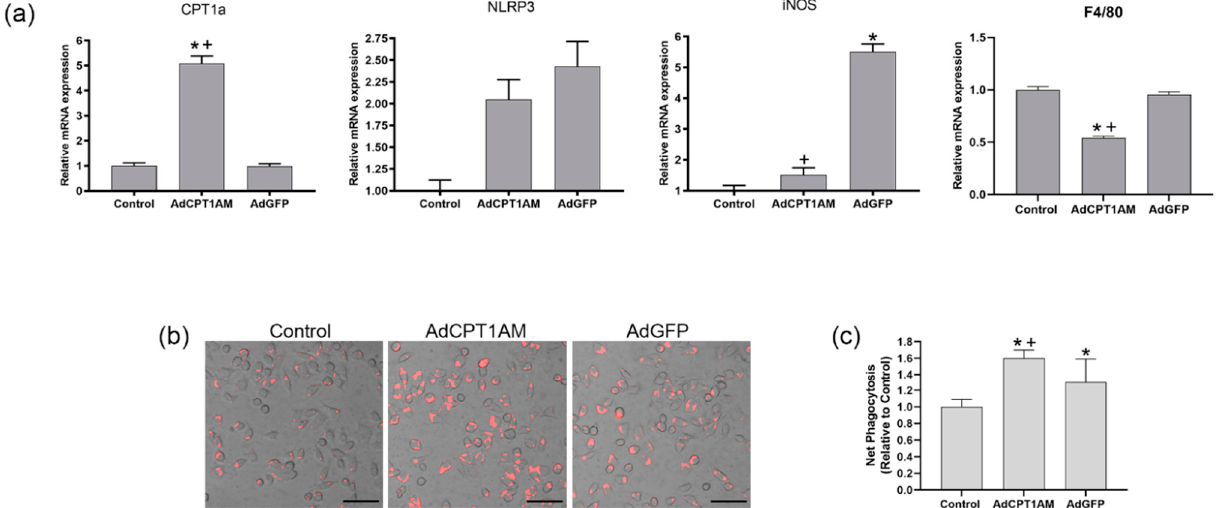
Figure 4. Phagocytic ability and mRNA analysis of CPT1AM-expressing Raw 264.7 macrophages. Murine macrophage Raw 264.7 was transduced with adenovirus carrying CPT1AM (AdCPT1AM) and GPF (AdGFP). Untransfected cells served as control. ( a ) mRNA expression determined by qPCR of CPT1a, NLRP3, iNOS and F4/80. ( b ) Representative images of pHrodo uptake captured by fluorescence microscopy. Objective magnification × 400, scale bar 50 µ m. ( c ) Net Phagocytosis of 55 µ g/mL pHrodo Red E. coli bioparticles conjugate for 90 min measured by spectrofluorometer. Data presented as mean ± SEM; n = 6 of three independent experiments; * p < 0.05 vs. control. + p < 0.05 vs. AdGFP.